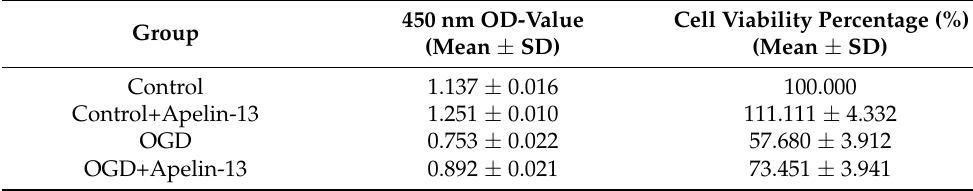
Figure 9. The flow cytometry results showed that compared with the OGD group, apoptosis in the OGD+Apelin-13 group was significantly reduced. **** p < 0.0001. ns, not significant. Table 2. Determination of cell viability under different conditions by CCK-8